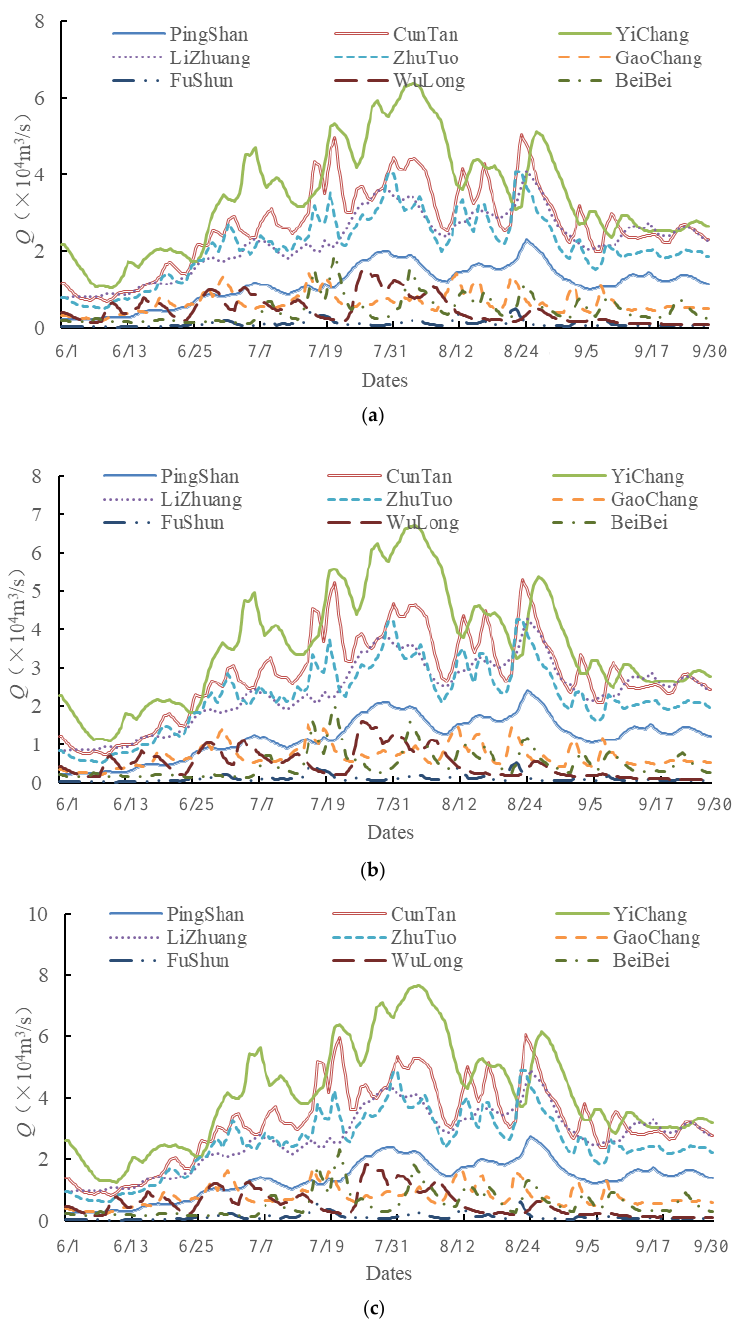
Figure 5. The 50-year, 100-year and 1000-year design flood hydrographs based on the typical flood hydrograph of 1954. ( a ) 50-year; ( b ) 100-year; ( c ) 1000-year. hydrograph of 1954. ( a ) 50-year; ( b ) 100-year; ( c )